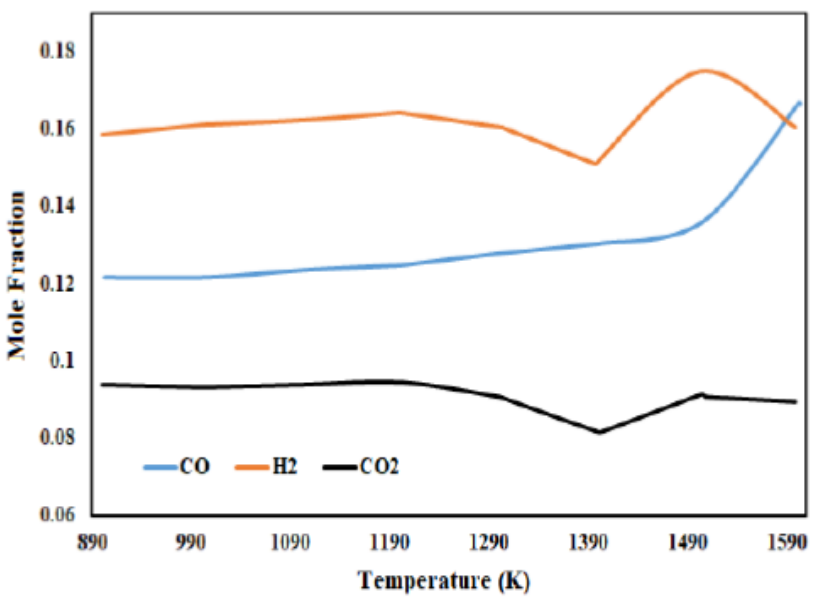
Figure 2. Syngas fraction of bituminous coal.